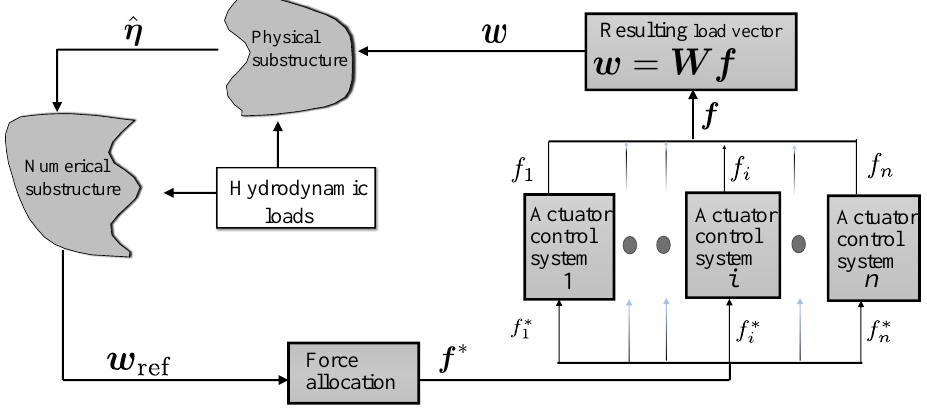
Figure 6. The ReaTHM testing